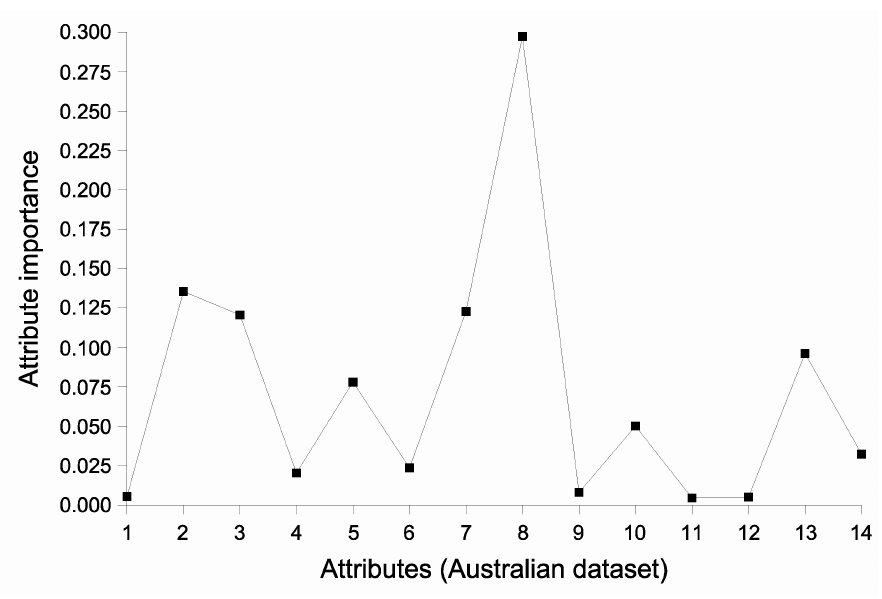
Figure 5. Relative importance of attributes predicted by boosted decision trees for the Aus- tralian dataset.